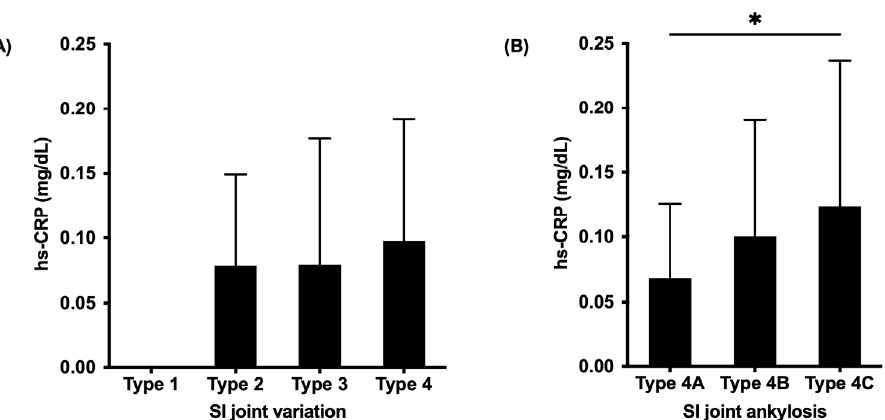
Figure 4. Comparison of serum high-sensitivity C-reactive protein levels between SI joint types ( A ) and subtypes ( B ) classifications [19,20]. SI, sacroiliac; hs-CRP, high-sensitivity C-reactive protein; *, p < 0.05.